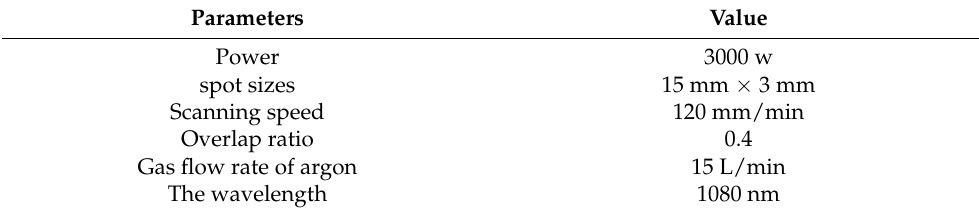
Table 1. Laser cladding